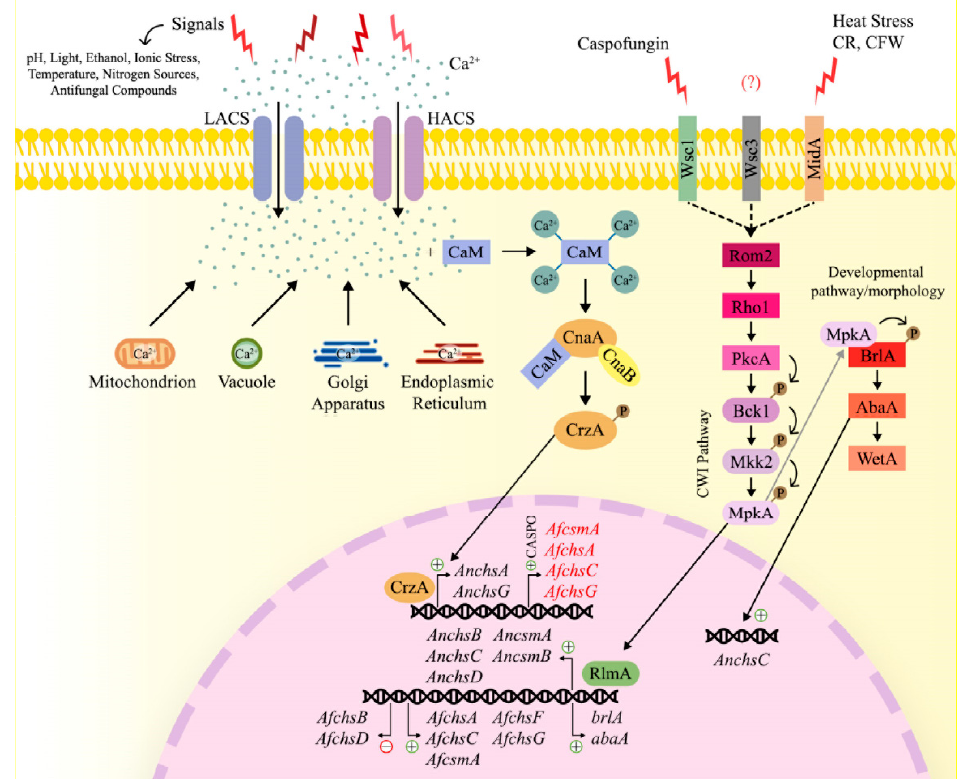
Figure 4. Regulation of chitin biosynthesis in response to extracellular signals and/or in the presence of stresses, including changes in pH, temperature, light, food sources and in the presence of antifungal compounds, an increase in intracellular Ca 2+ concentrations occur. Calcium channels regulate the influx of calcium through the “High affinity Ca 2+ influx system” (HACS), which is activated when Ca 2+ availability is low, or the “Low affinity Ca 2+ influx system” (LACS), when calcium availability is high. In addition, Ca 2+ ions are also released from intracellular stores, such as mitochondria, vacuoles, the Golgi apparatus and the endoplasmic reticulum. Upon an increase in cytosolic Ca 2+ concentrations, the protein Calmodulin (CaM) binds to 4 Ca 2+ molecules, which triggers conformational changes in this enzyme. Subsequently, CaM is able to bind to calcineurin, a heterodimeric protein composed of catalytic (CnaA) and regulatory (CnaB) subunits, and activate it. Calcineurin, in its active form, phos- phorylates the transcription factor CrzA, which subsequently translocates to the nucleus. CrzA binds to the promoter region of several A. nidulans chitin synthase-encoding genes, including AnchsA and AnchsG , initiating transcription of these genes. In A. fumigatus , the calcium-calmodulin-calcineuring signaling pathway is also activated during the caspofungin paradoxical effect (CPE), where CrzA binds to the promoter region of AfcsmA, AfchsA, AfchsC and AfchsG . In addition, the antifungal